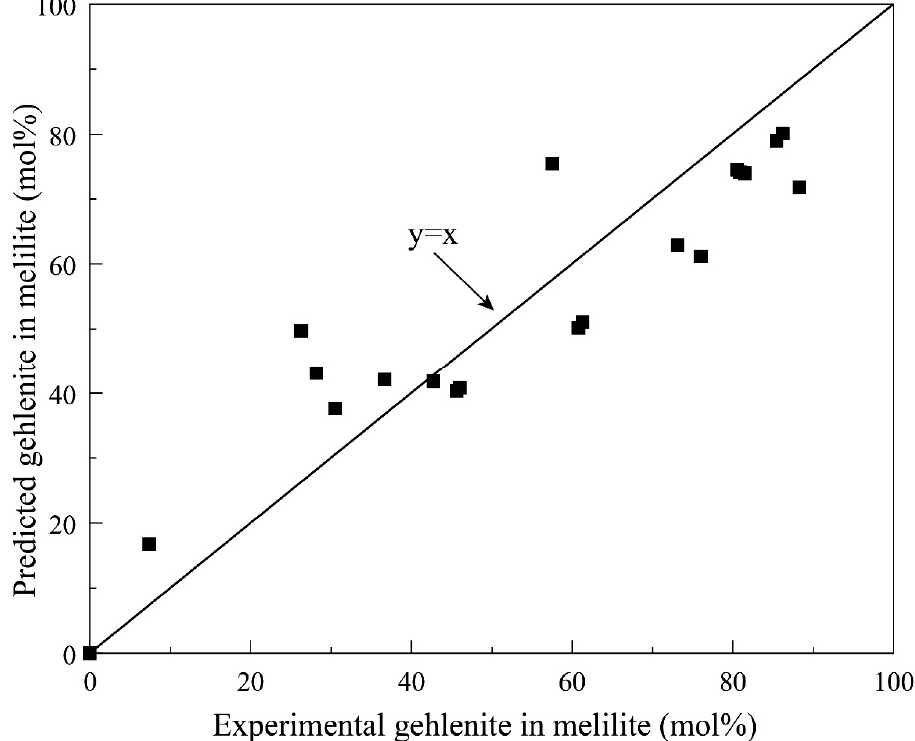
Figure 20. Comparison of the melilite composition between experimental data and FactSage predictions [23].